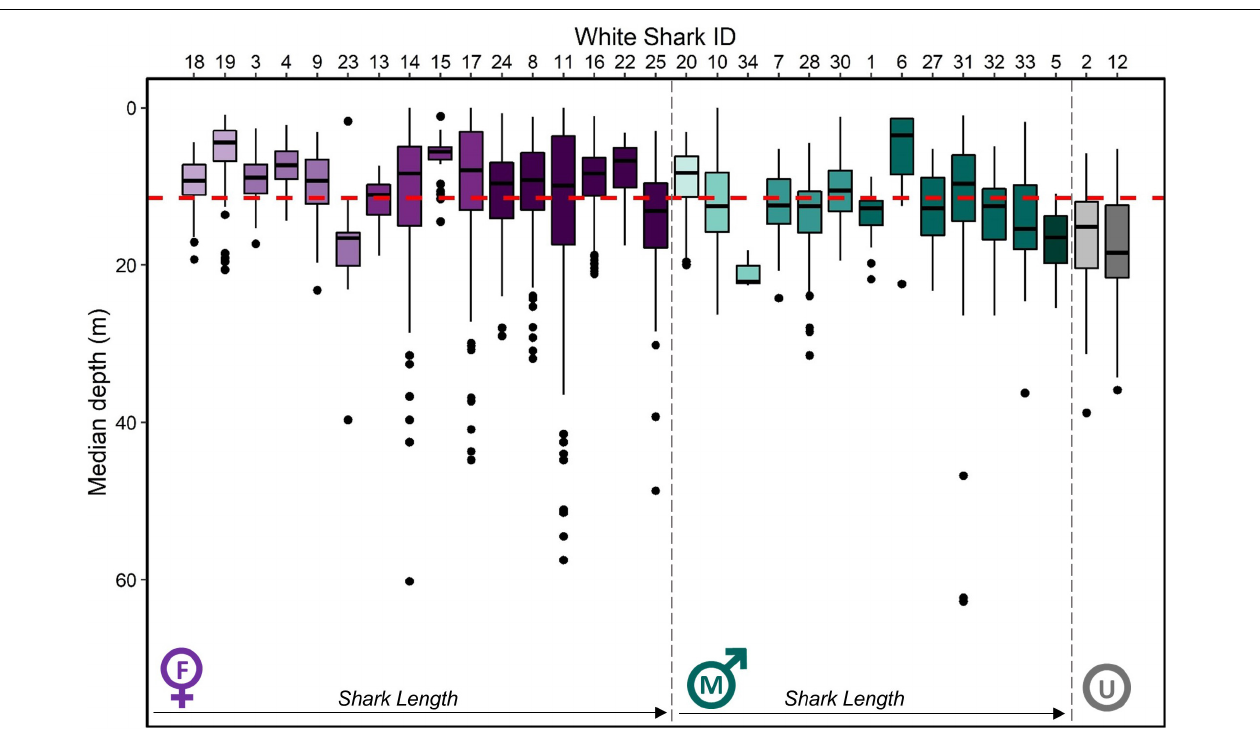
FIGURE 3 | Median depth (m) by individual white shark Carcharodon carcharias in the coastal phase of their migration in the NE Pacific. Boxplots are ordered firstly by sex (female = purple, male = green, unknown = gray) then by size (small to large from left to right), with darker shades indicating larger individuals. The red dashed line indicates the average median depth of all individuals (11.7 ± 8.4 m), while the average median depth for female and male individuals is 10.6 ± 9.1 m and 11.7 ± 6.4 m,